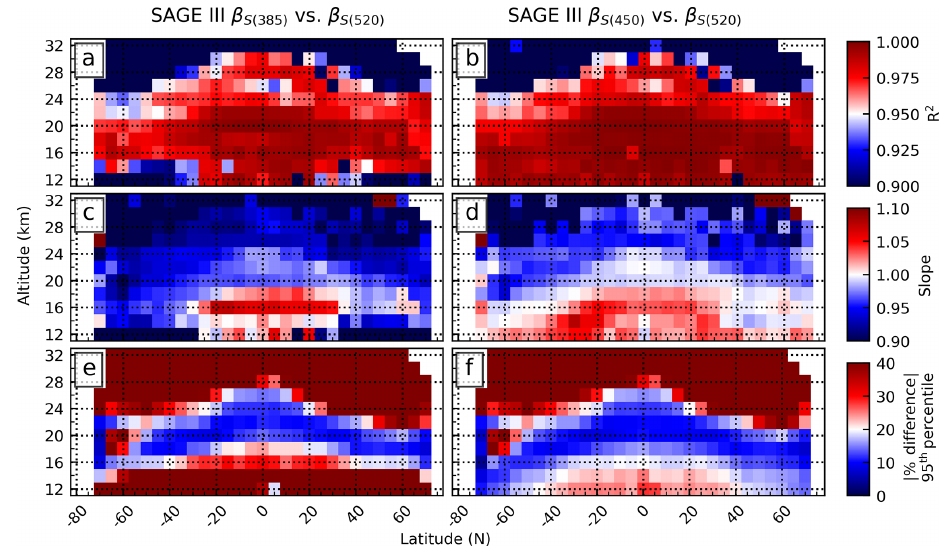
Figure 5. Same as in Fig. 4, but for the SAGE III